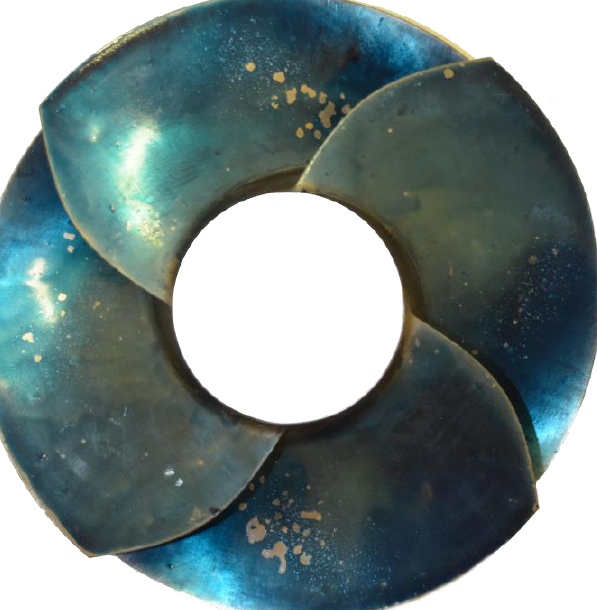
Figure 8. Cavitation erosion zones on the suction surface of rimless impeller № 2 ( Q = 0.3 × Q BEP , NPSH = 3.65 m).